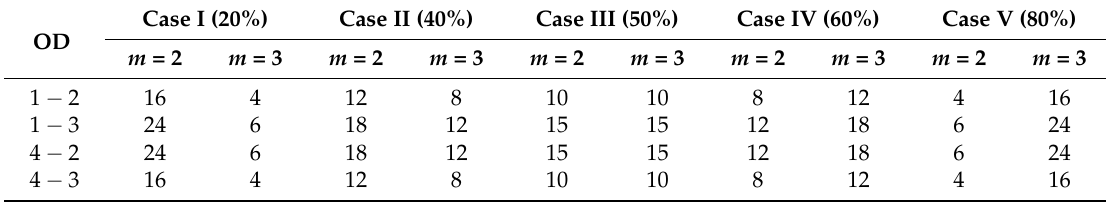
Table 11. Agent numbers with various range anxiety levels for one OD